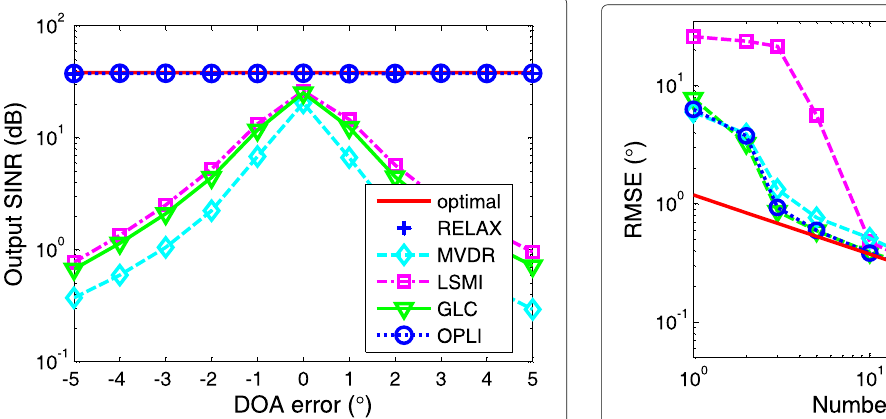
Figure 6 examines the influence of angular separation on DOA estimation, where K = 2 signals impinging from 5.3° − (cid:6) and 5.3° are considered. (cid:6) ranges from